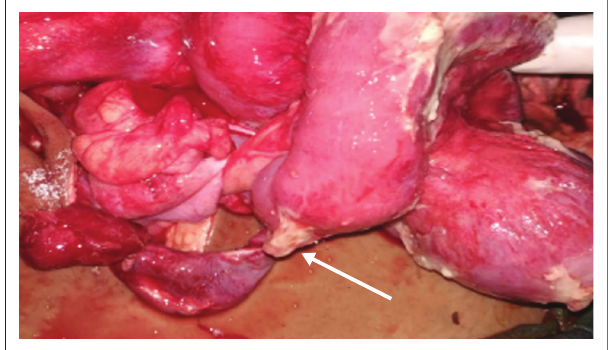
FIGURE 3: Intraoperative image demonstrated the inflamed Meckel’s diverticulum (white arrow) causing a stricture of the distal ileum resulting in intestinal